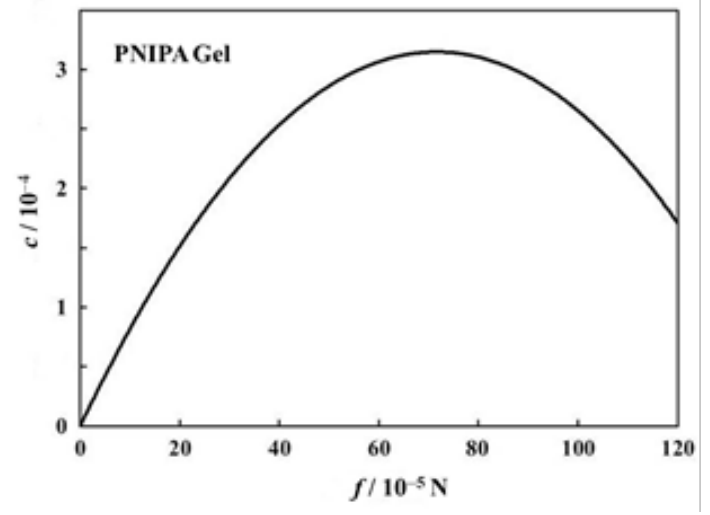
Figure 10. of performance of the PNIPA gel as a function of force [40]. Figure 10. Coe ffi cient of performance of the PNIPA gel as a function of force Figure 10. Coefficient of performance of the PNIPA gel as a function of force [40].